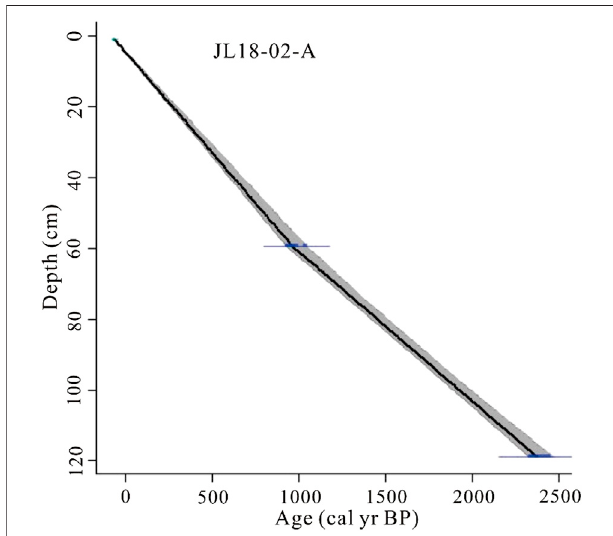
Frontiers in Earth Science |